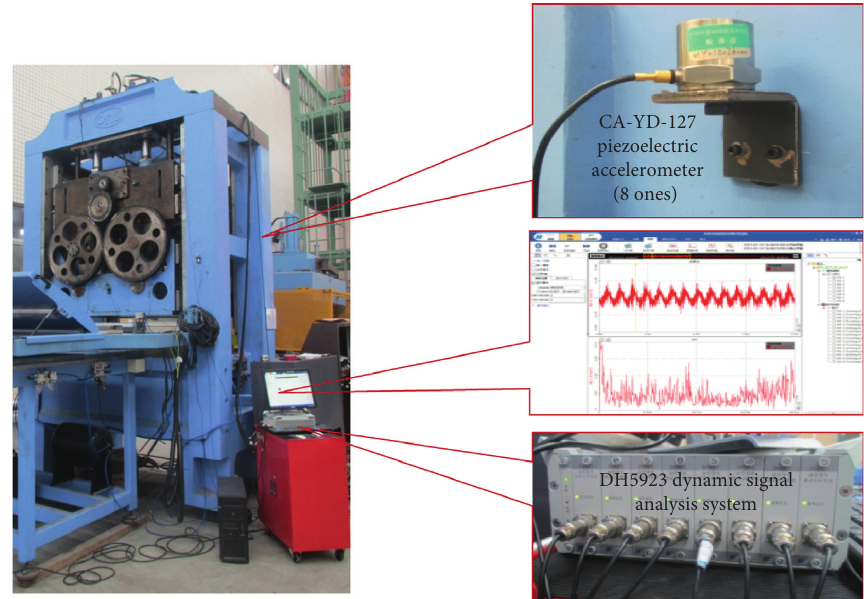
Figure 7: Acceleration test experiment of main parts.